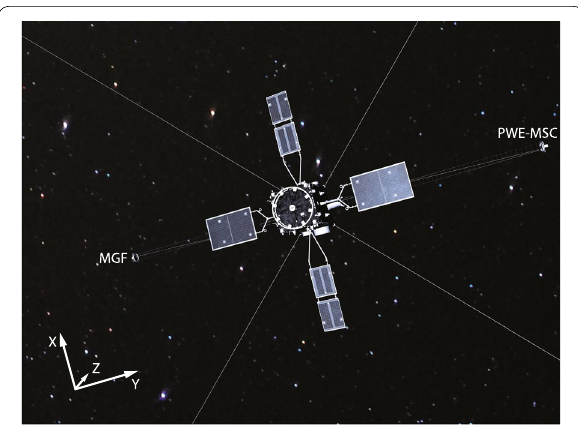
Fig. 1 Arase satellite in the SGA coordinates. The Z axis is located along the satellite spin axis. This figure is a modification of an original version produced by the ERG project